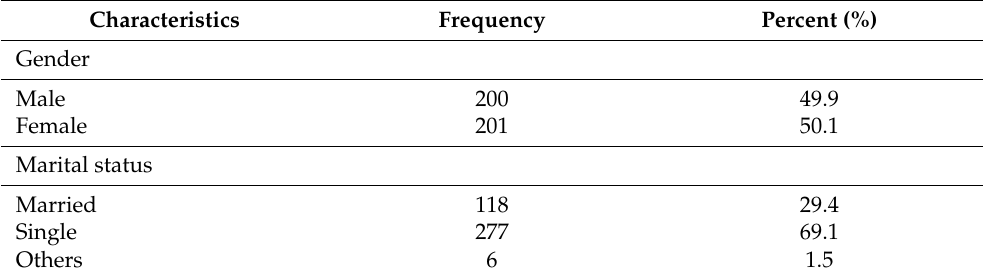
Table 1. Sociodemographic characteristics of respondents.